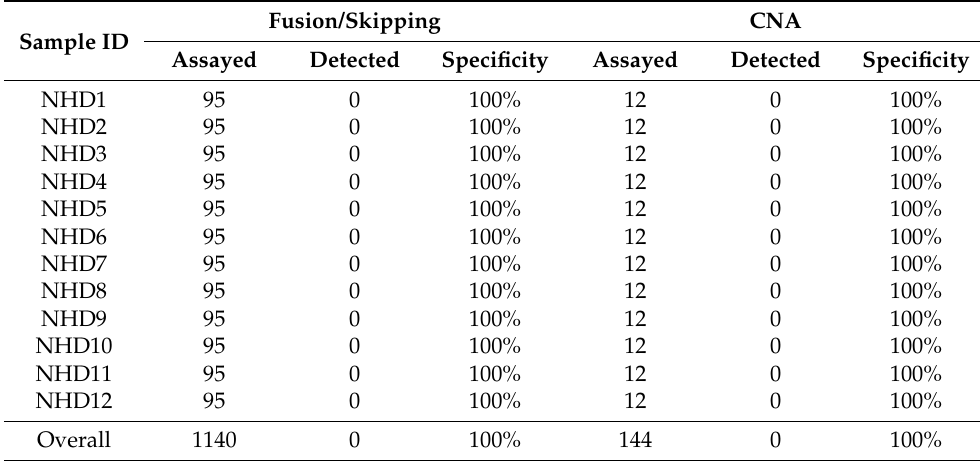
Table 3. Assay specificity in normal healthy donor specimens